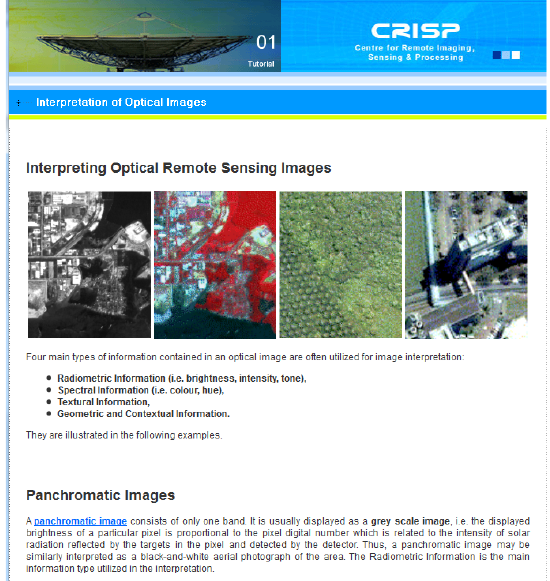
Figure 1: CRISP – Interpreting Optical Remote Sensing http://www.crisp.nus.edu.sg/~research/tutorial/intro.htm